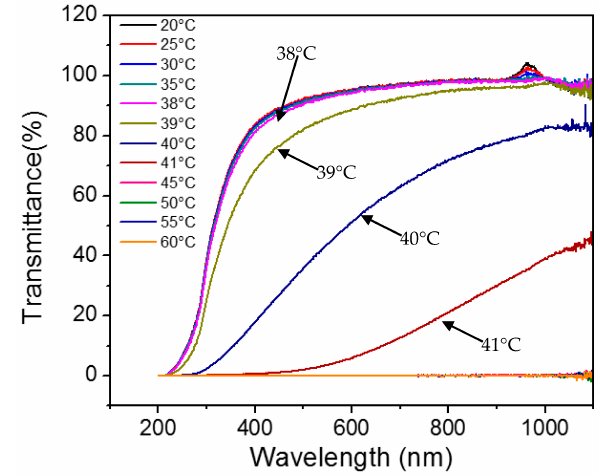
Figure 2. Transmittance of the 6 wt. % Hydroxypropyl cellulose (HPC) for the spectra from 200 nm to 1100 nm over the temperature range 20–65 °C.